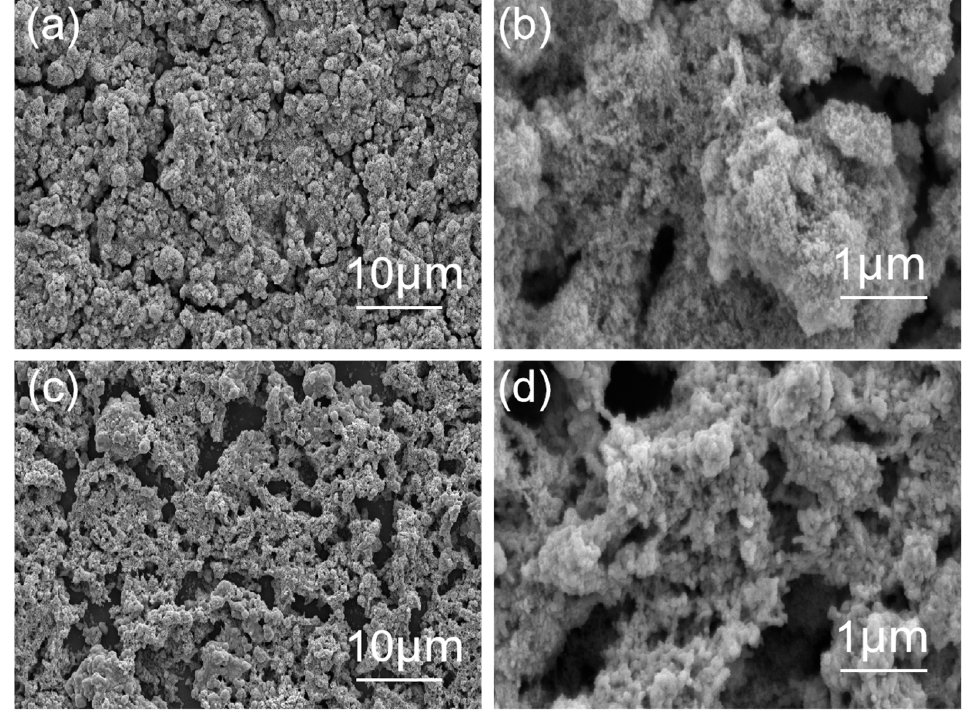
Figure 4. Morphologies of ink before/after laser irradiation: ( a , b ) before scanning; ( c , d ) after irradiation.